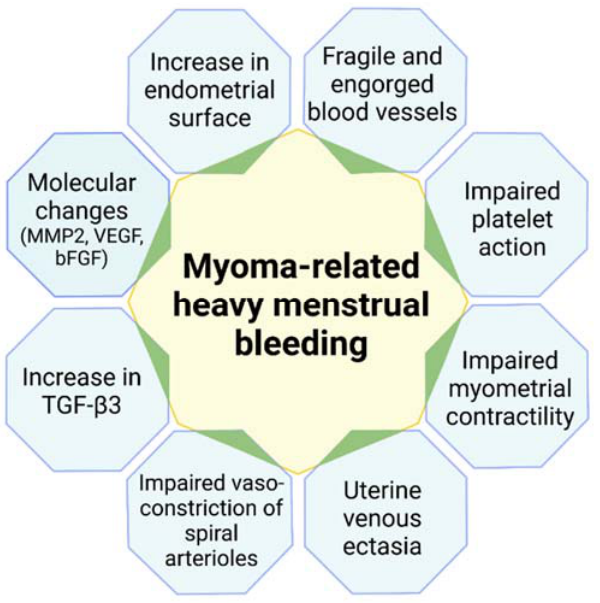
Figure 2. Mechanisms linking uterine fibroids and heavy menstrual bleeding. MMP-2: matrix metalloproteinase; VEGF: vascular endothelial growth factor; bFGF: basic fibroblast growth factor; TGF ‐ β 3: transforming growth factor ‐β 3.